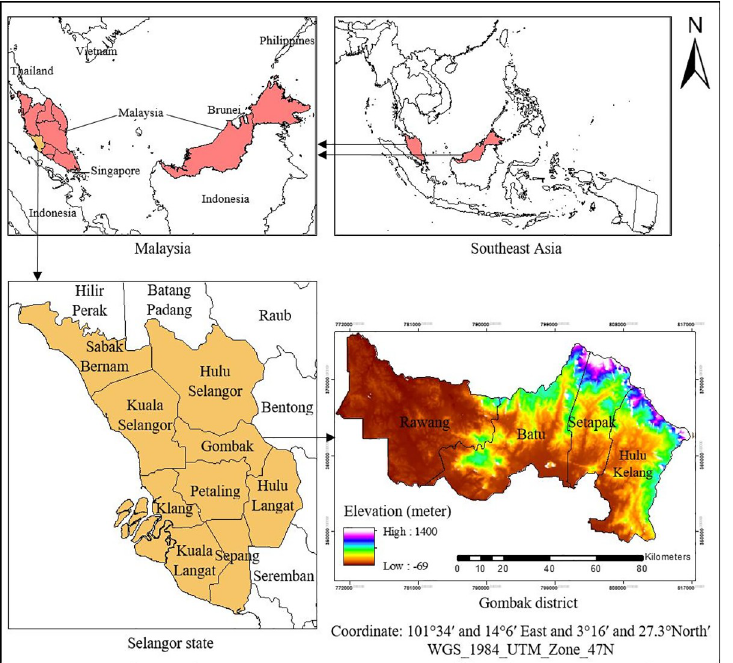
Fig 1. Geographical location of Gombak in the states of Selangor and mukims of Gombak.